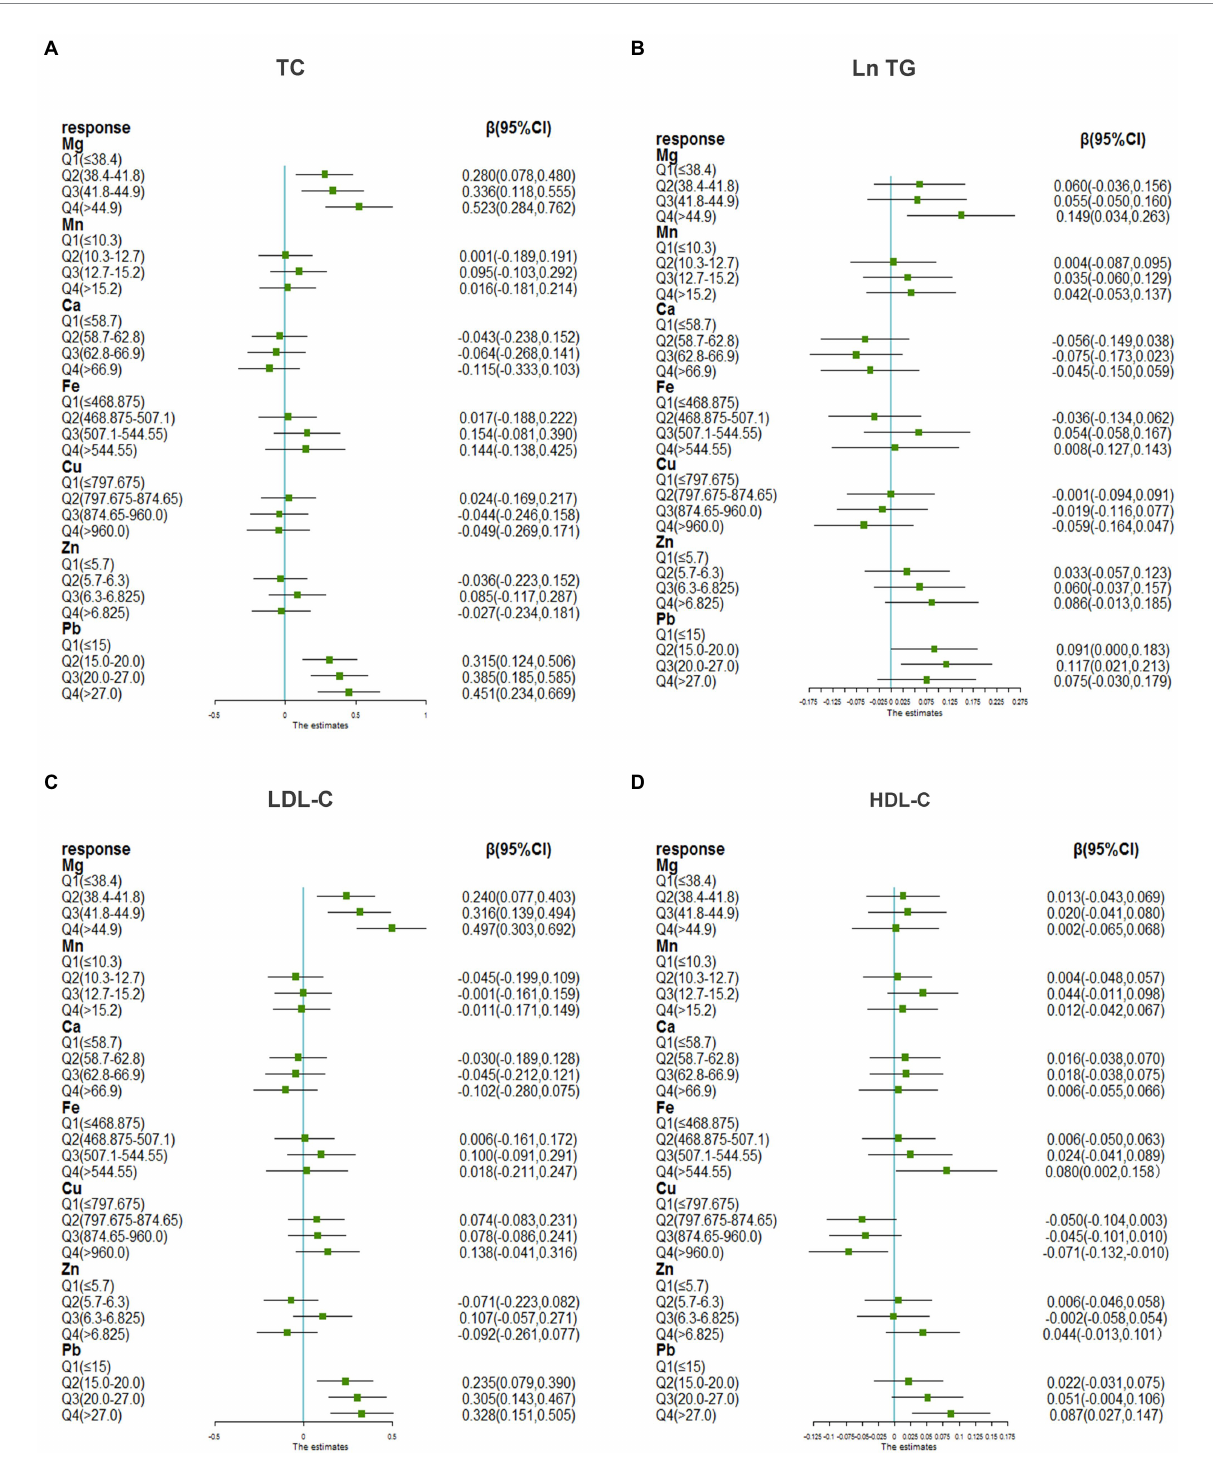
FIGURE 1 The associations of blood Pb and essential metals with serum lipid profiles using multivariable liner regression. (A) Metals and TC, (B) metals and Ln TG, (C) metals and LDL-C, (D) metals and HDL-C. TG was transformed to natural logarithm and metal concentrations were grouped into quartiles for further analysis. The model was adjusted for age, sex, educational, smoking status, abuse drinking, BMI categories, diabetes, and hypertension. TC, total cholesterol; TG, triglyceride; LDL-C, low-density lipoproteins cholesterol; HDL-C, high-density lipoproteins cholesterol; BMI, body mass index; Mg, magnesium; Mn, manganese; Ca, calcium; Fe, iron; Cu, copper; Zn, zinc; Pb,